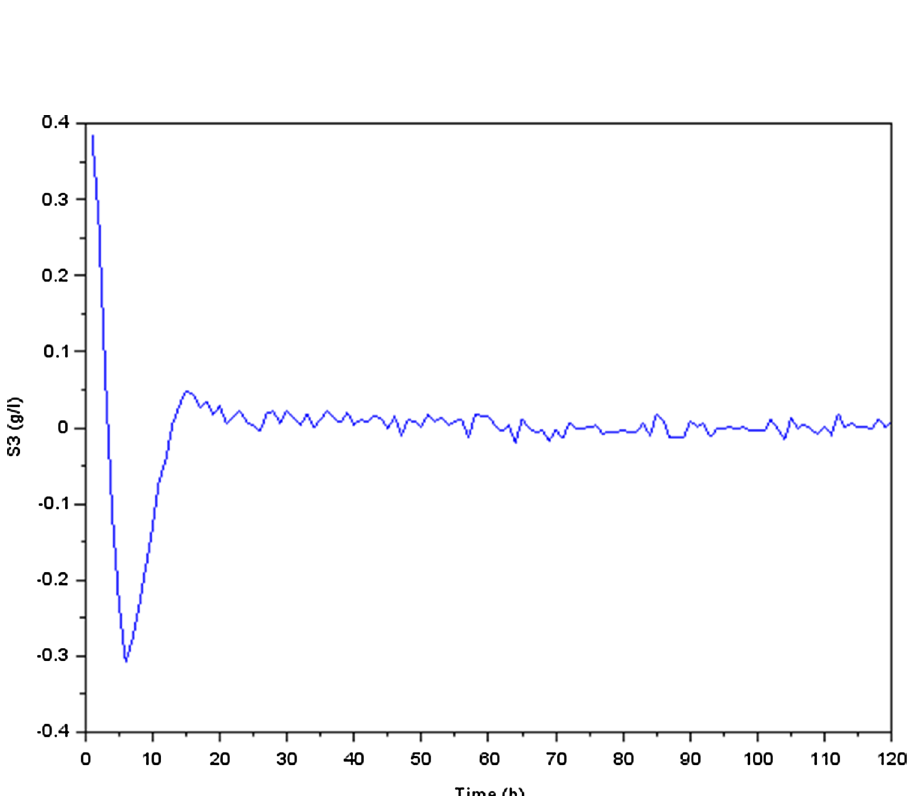
Figure 9. Variation of carbon dioxide concentration S 3